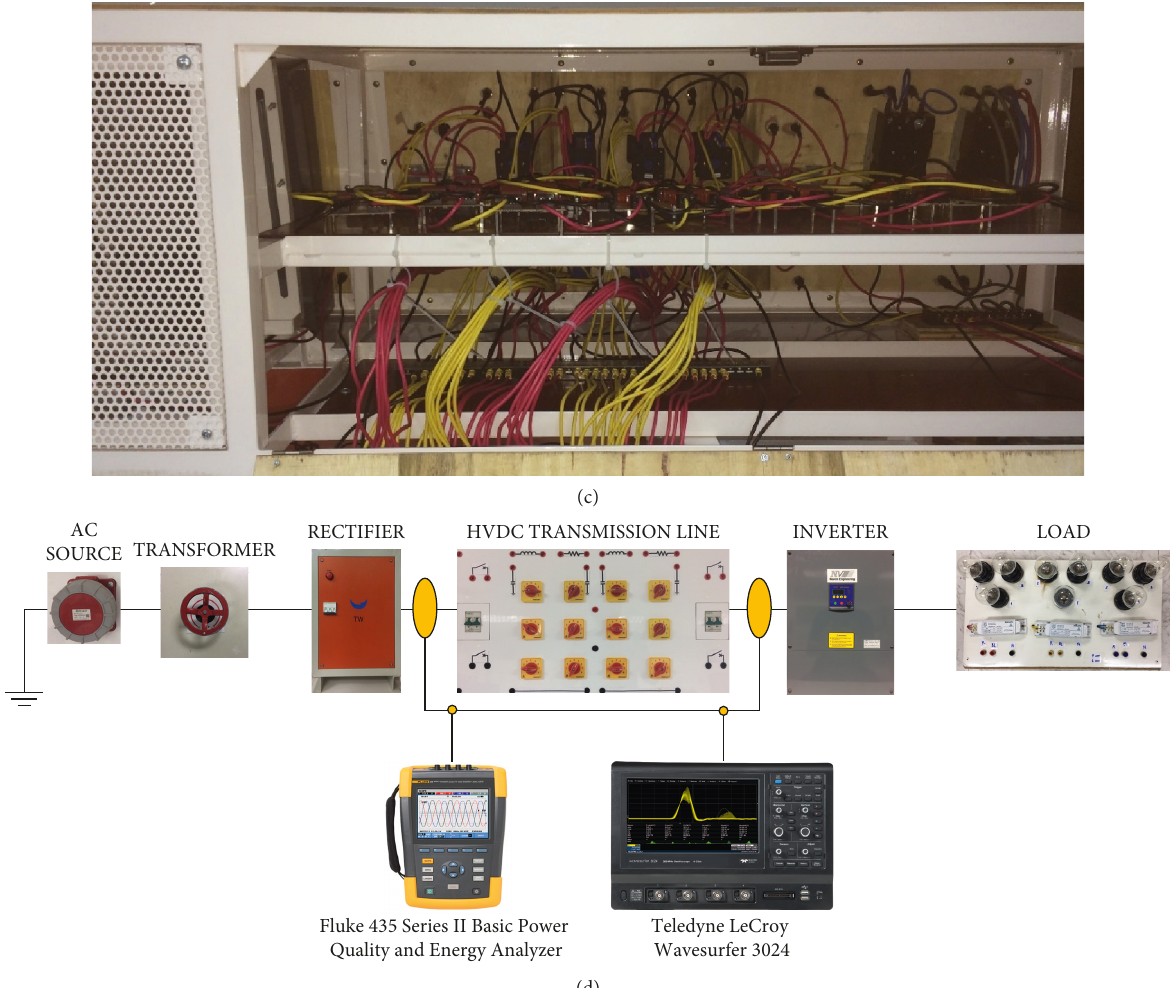
Figure 8: Experimental setup of the HVDC transmission line. (a) Schematic diagram of the experimental setup, (b) experimental setup, (c) behind the experiment setup, and (d) measurement points of the experimental